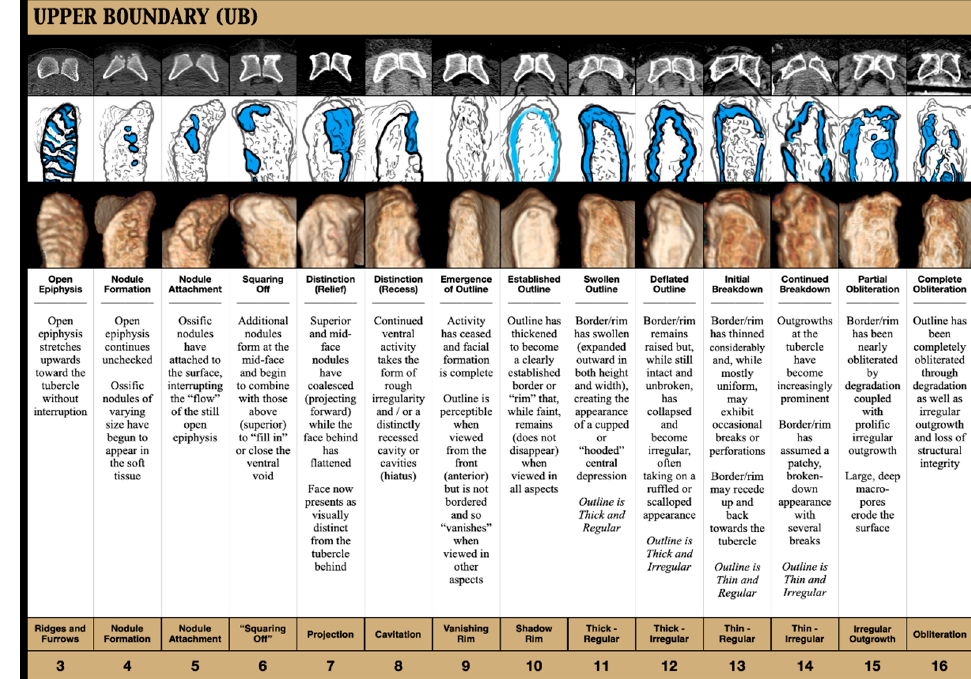
Figure 2. The Upper Boundary.